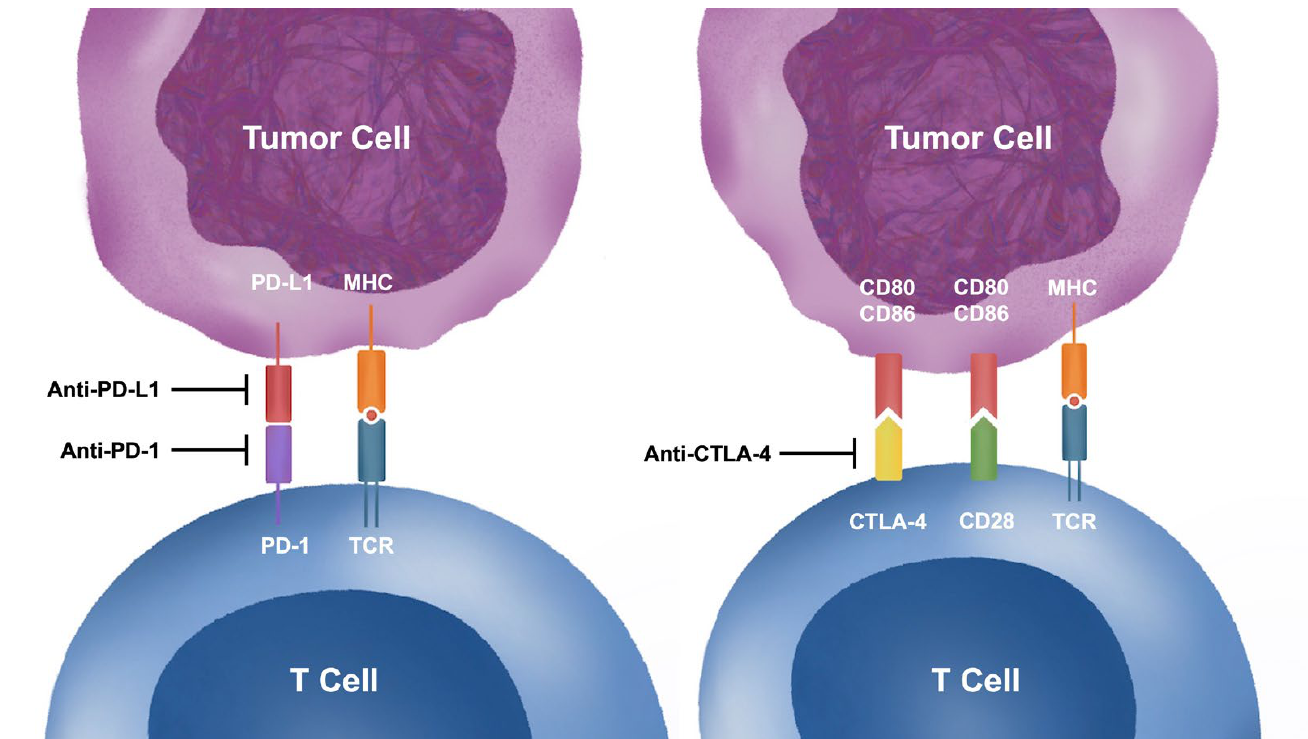
Figure 1. Mechanisms of Immune Checkpoint Inhibitors. Binding of programmed ligand-1 (PD-L1) of tumor cells to programmed death 1 (PD-1) receptors of T cell reduces T cell proliferation, down- regulates cytokine expression and induces apoptosis. Anti-PD-1 and anti-PD-L1 monoclonal anti- bodies are used to inhibit PD-1/ PD-L1 axis, thereby increasing anti-tumor activities by T cells. CD28 of T cells are co-stimulatory receptors that bind CD80/ CD86 of tumor cells to activate T cells. Cyto- toxic T-lymphocyte-associated protein 4 (CTLA-4) competitive bind CD80/CD86 and thereby reduce T cell activation. Anti-CTLA-4 monoclonal antibodies inhibit CTLA-4 activities, increase CD28 co- stimulatory signaling and enhance T cell activities against tumor cells. Abbreviations: CTLA-4, cy- totoxic T-lymphocyte-associated protein 4; MHC, major histocompatibility complex; PD-1, pro- grammed death 1; PD-L1, programmed death ligand-1; TCR, T cell receptor.